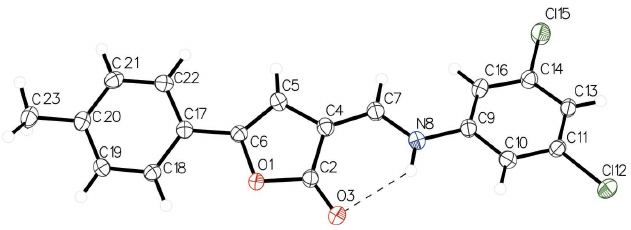
Figure 1 The molecular structure of the title compound with the atom labelling and displacement ellipsoids drawn at the 50% probability